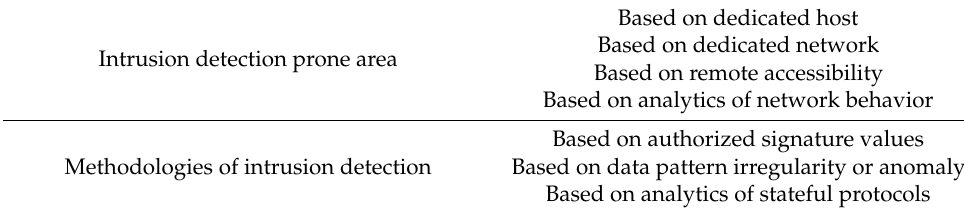
Table 1. Summary of some of IDS